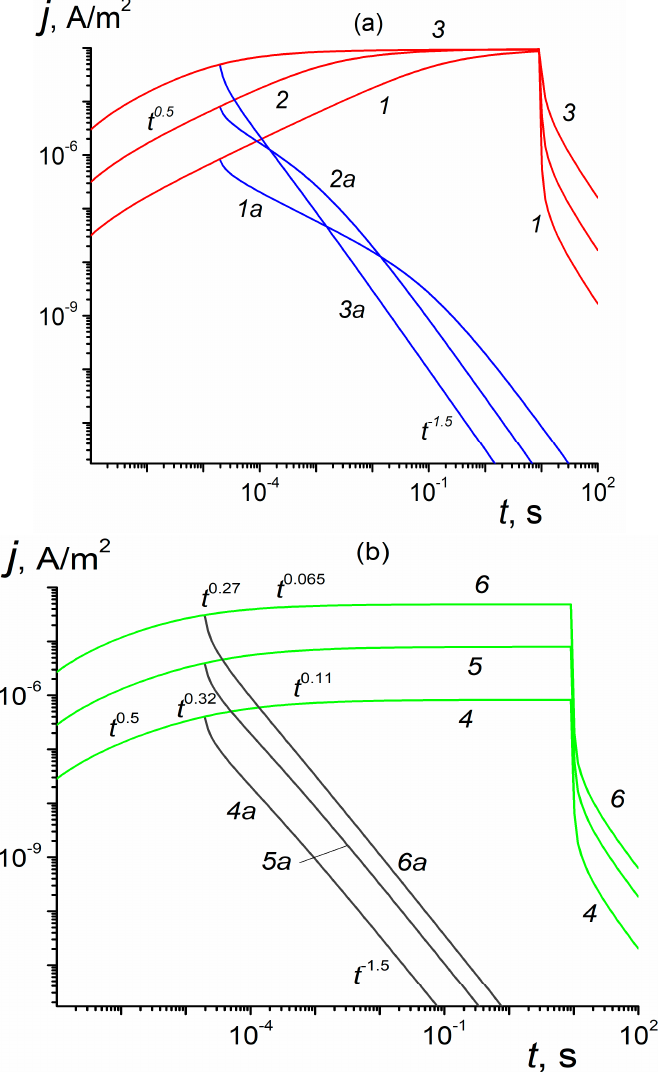
Figure 2. Calculated TOF-2 build-up and decay curves for a prototype polymer taken for two τ c : 5.4 × 10 3 ( a ) and 5.4 × 10 − 10 s ( b ). Also, irradiation times 20 μ s (1a–6a) and 10 s (1–6) and electric fields 10 7 10 3 ( a ) and 5.4 × 10 − 10 s ( b ). Also, irradiation times 20 µ s (1a–6a) and 10 s (1–6) and electric fields 10 (1,1a,4,4a), 10 8 (2,2a,5,5a) and 10 9 V/m (3,3a,6,6a); g 0 = 10 20 m − 3 ·s − 1 . Recombination neglected, film